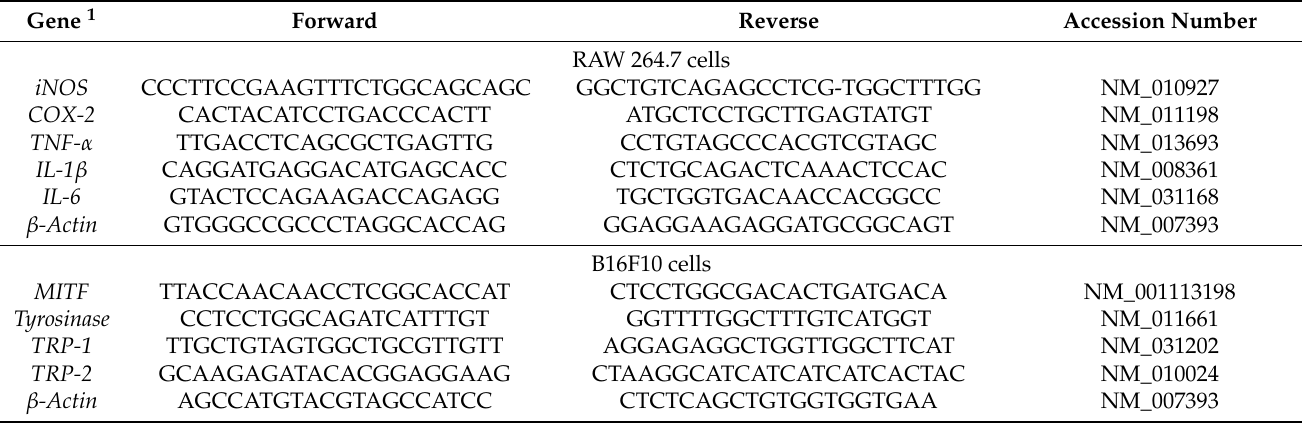
Table 1. Primer sequences for detection of